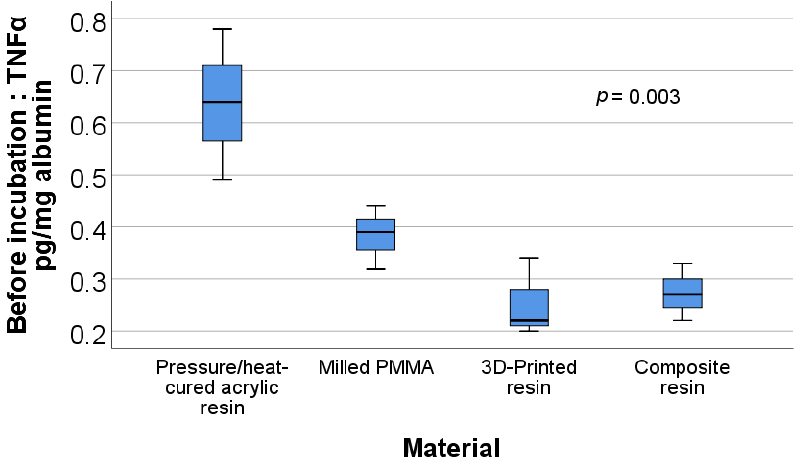
Figure 6. Box plot representation of the comparison between TNF α /albumin ratio values—after incubation for each material type.